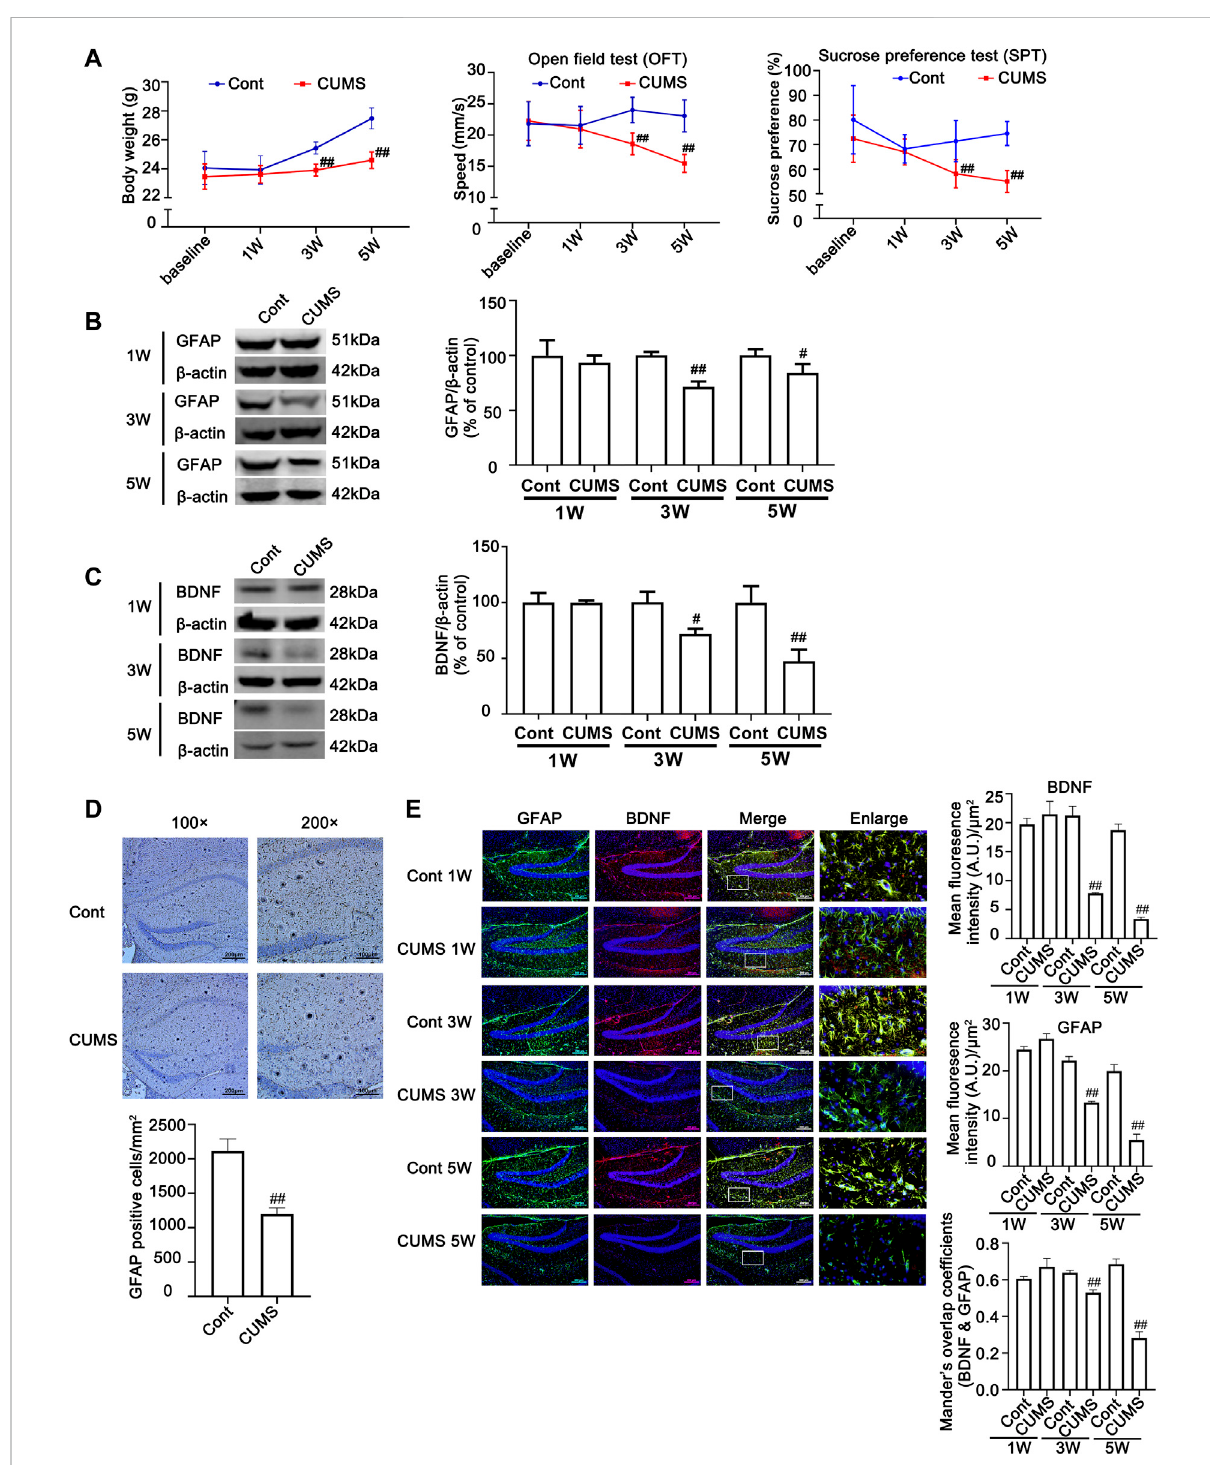
Chronic unpredictable mild stress (CUMS) treatment induces depressive-like behaviors and reduces body weight gain, accompanied by a reductioninastrocytes andadecreaseinBDNFinthemouse hippocampus.MiceweretreatedwithCUMSfor 1,3and5 weeks (A) Line chart ofbody weight, open fi eld test and sucrose preference test in mice. The results are expressed as the mean ± SD (n = 8 per group). ## p < 0.01, vs. Cont. group. Statistical comparisons were carried out with multiple t tests with the Bonferroni-Dunn method . (B and C) Changes in GFAP and BDNF expression over different time courses after CUMS treatment, as determined by Western blot analysis. β -actin protein was used as a loading control. ImageJ software was used for immunoblot quanti fi cation, and statistics were performed by Student ’ s t test . Mean ± SD , n = 3 per group, # p <